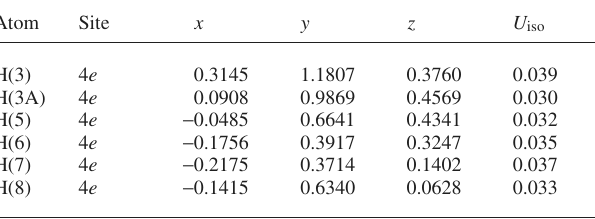
Table 2. Atomic coordinates and displacement parameters (in Å 2 )